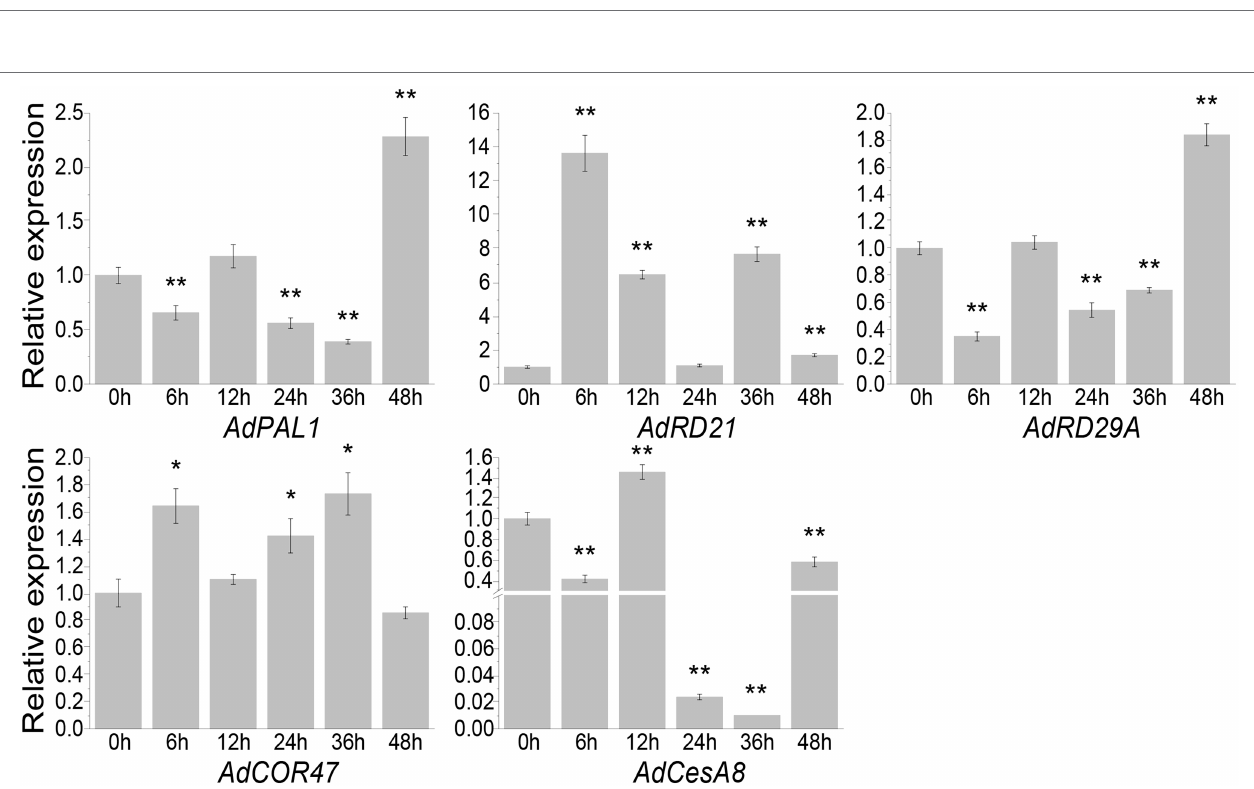
FIGURE 5 | Differentially expressed AdWRKYs under drought stress detected by quantitative real-time PCR (qRT-PCR). Four-leaf plants were treated with 10% (w/v) PEG6000. The leaves were collected after 0, 6, 12, 24, 36, and 48 h of treatments. The control was sampled from 0 h. Three biological replicates were used. Asterisks * and ** indicate significant differences at 0.05 and 0.01 using t tests, respectively.